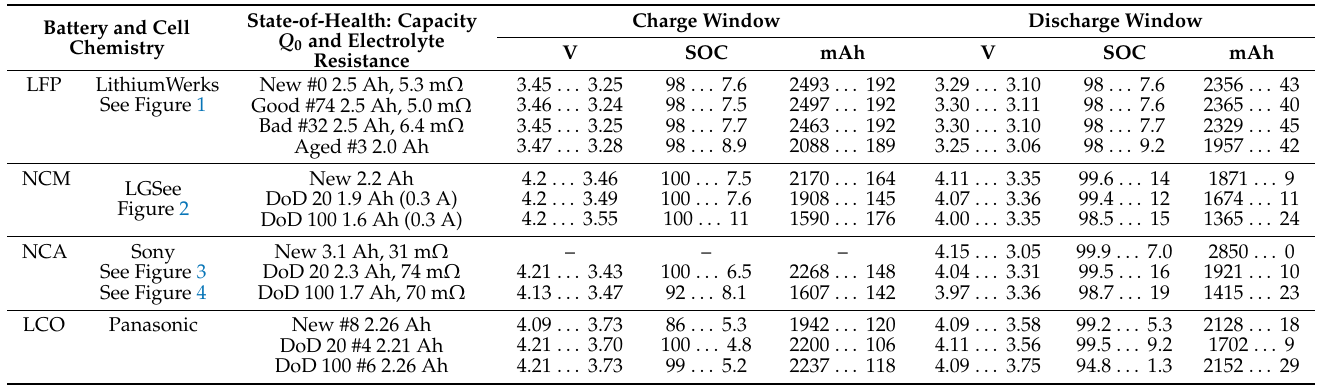
Table 2. Intersection criterion for lithium-ion batteries at the beginning of life and end of life: Cell voltage U , state-of-charge (SOC = Q / Q 0 in %) and available electric charge Q ( Q 0 = capacity at full charge) at the upper and lower intersection: d Q /d U = d U /d Q ≈ 1.